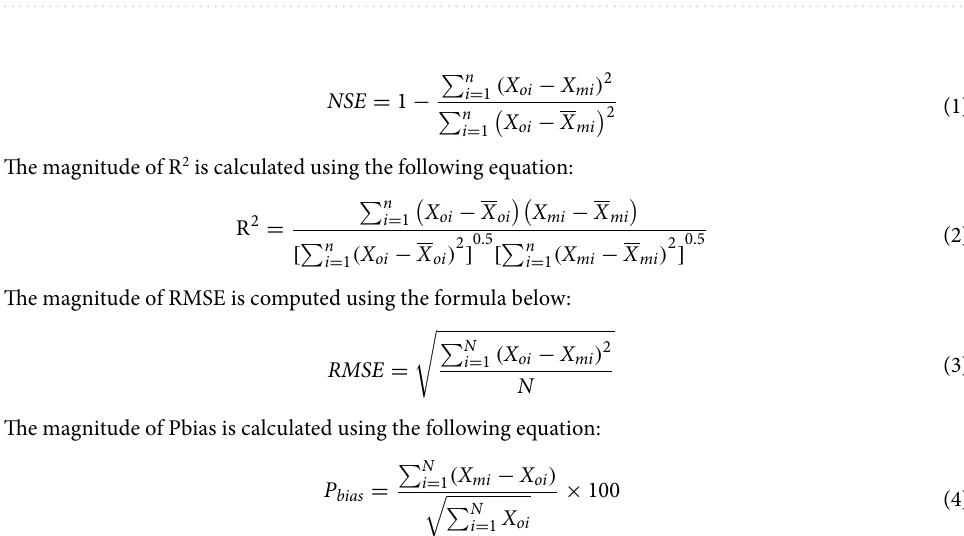
Table 2. List of selected predictors in the Ishikari River basin. Mean temperature at 2 m (temp), mean sea level pressure (mslp), total precipitation (prcp), surface downwelling longwave flux in air (rlds) and surface downwelling shortwave flux in air (rsds) in monolevel, specific humidity (#_shum), relative humidity (#_ rhum), geopotential height (_p), geostrophic air flow velocity (#_f), vorticity (#_z), zonal velocity component (#_u), meridional velocity component (#_v), divergence (#_zh), and wind direction (#_th) under the pressure level of 500 hPa, 700 hPa, 850 hPa, as well as 1000